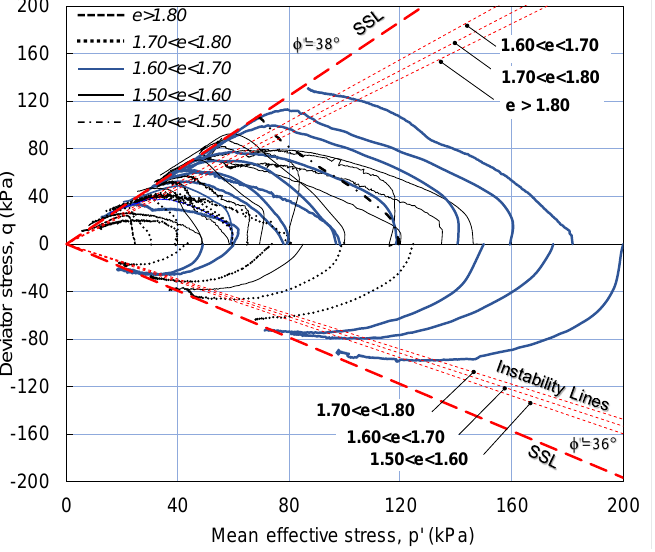
Figure 8. Stress paths in compression and extension tests.